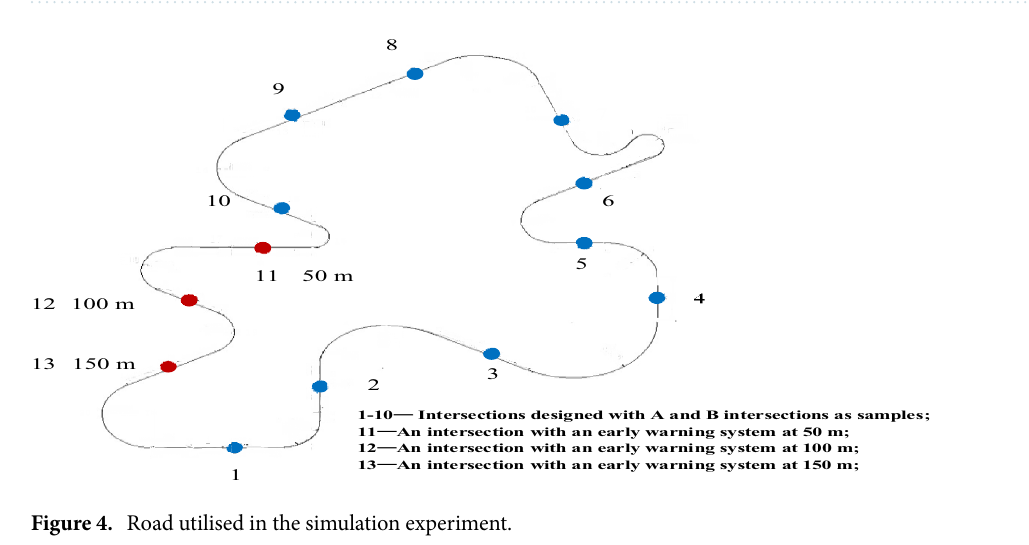
Figure 3. Plan and virtual scenarios of the three intersections.